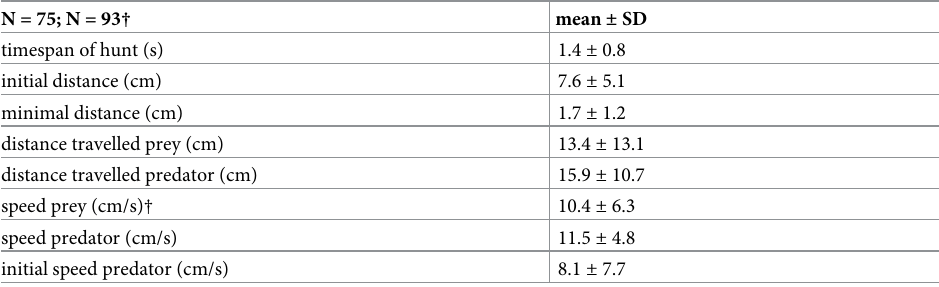
Table 1. Performance data of predator and prey fish during the